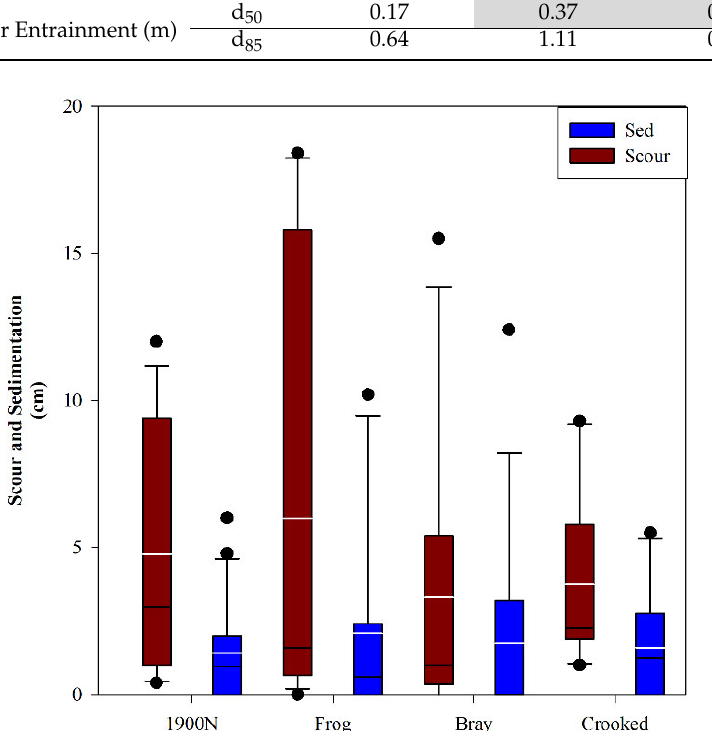
Figure 7. Scour and sedimentation in each stream. The ends of the boxes represent the 25th and 75th percentiles with the solid black line at the median and the solid white line at the mean; the error bars depict the 10th and 90th percentiles and the points represent the 5th and 95th percentiles.